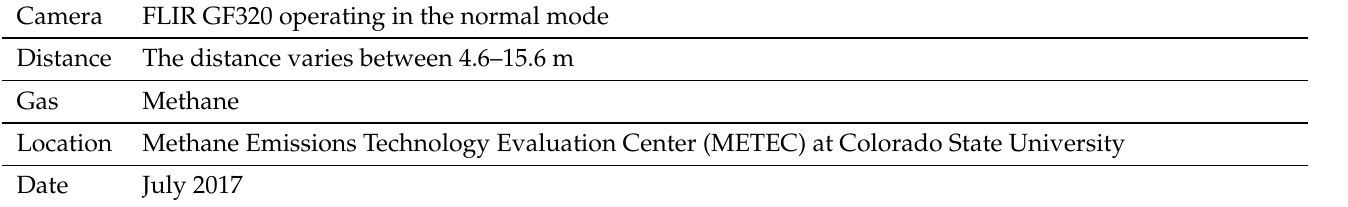
Table 2. Details of the Experiment B.